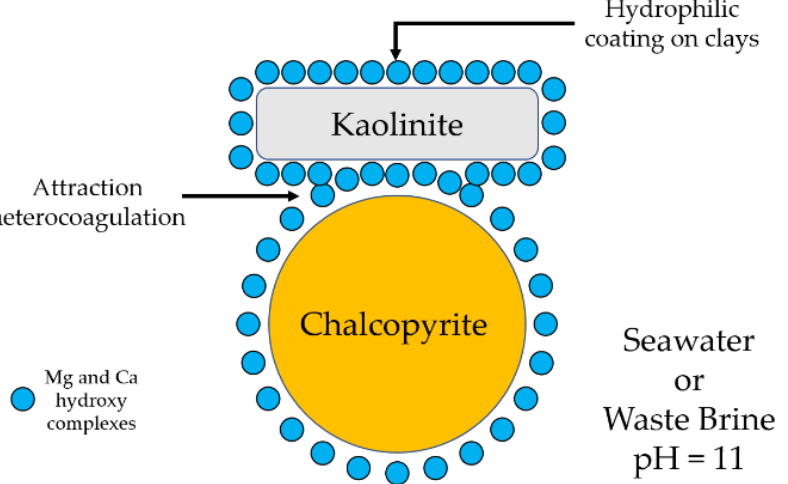
Figure 5. Schematic illustration of the interaction mechanism between kaolinite and chalcopyrite using seawater or waste brine at pH 11. Adapted from [32].